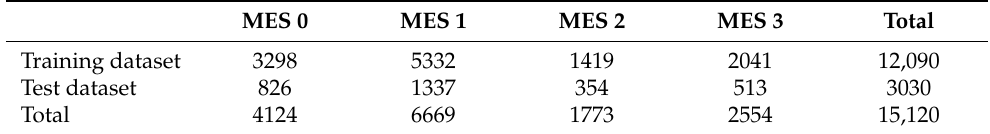
Table 2. Distribution of experimental datasets.